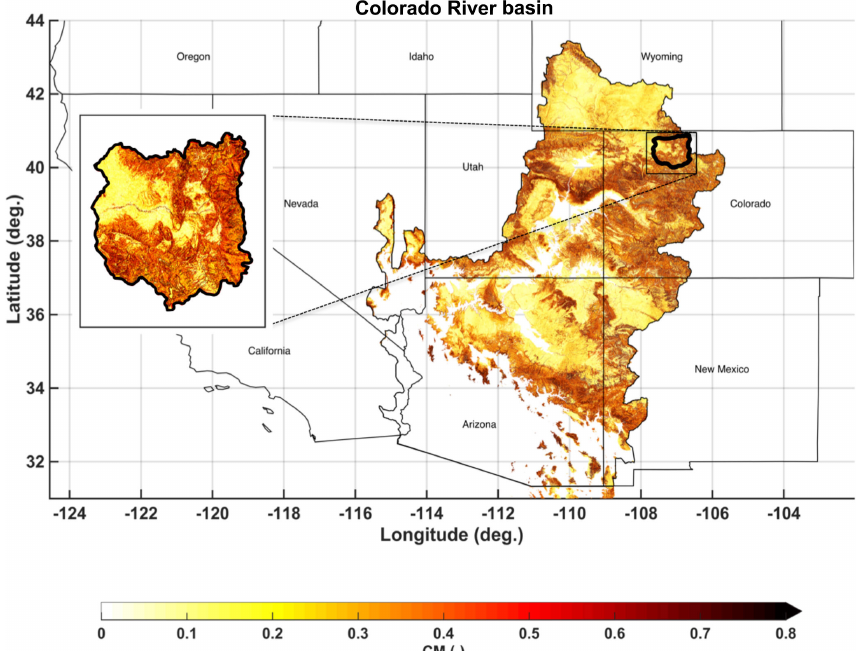
Figure 1. Complexity metric (CM) map of the Colorado River basin (CRB) with the upper Yampa River basin (UYRB) outlined in black and displayed in more detail in the subpanel.